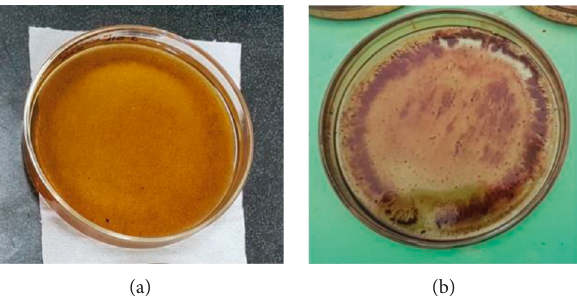
Figure 4: (a) Soft deposit in n-heptane. (b) Soft deposit after drying (obtained at 275 ° C, 100 RPM, after 80 hours of test run). Sample Preparation TGA